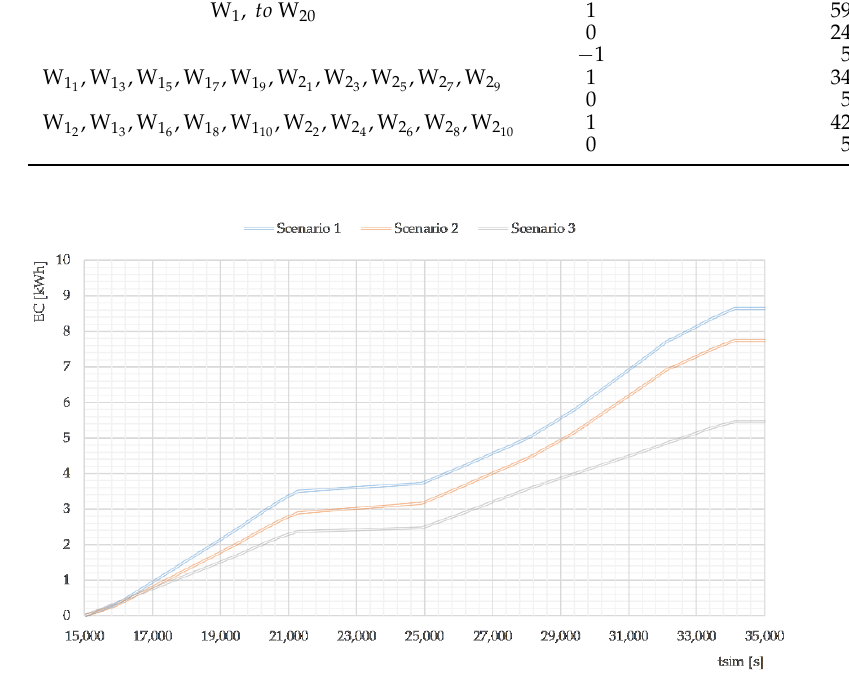
Figure 7. Energy consumption during the simulation experiment.